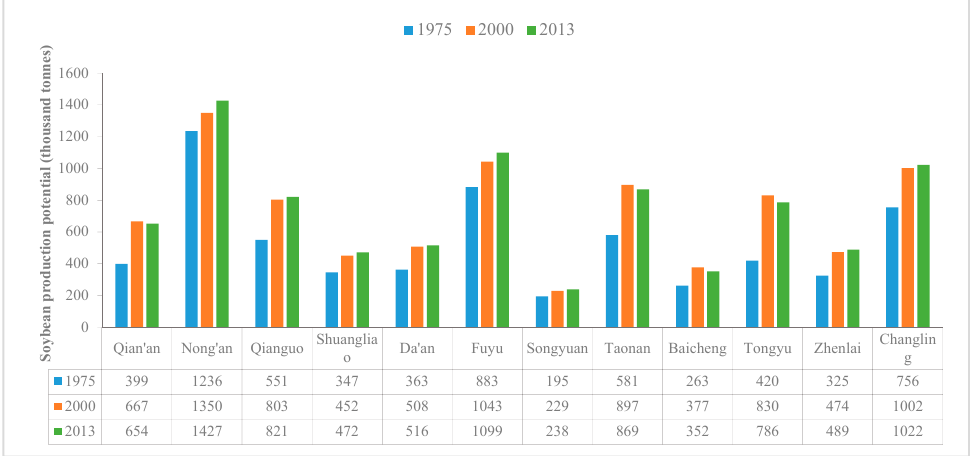
Figure 9. Soybean production potential in Western Jilin in 1975, 2000 and 2013 under Scenario I.